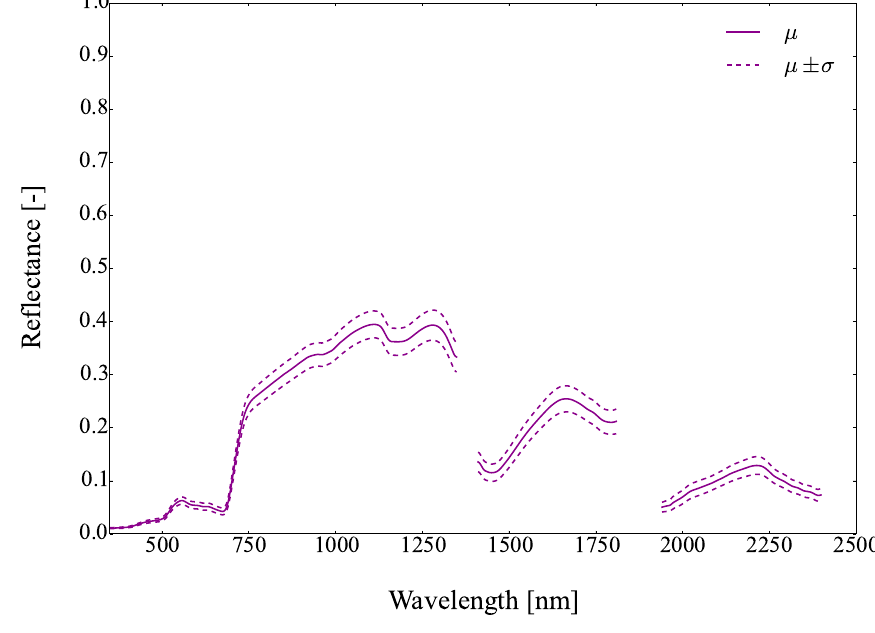
Figure A26. Mean reflectance ( µ ) and standard deviation ( σ ) of Pinguicula sp. combined vegetation